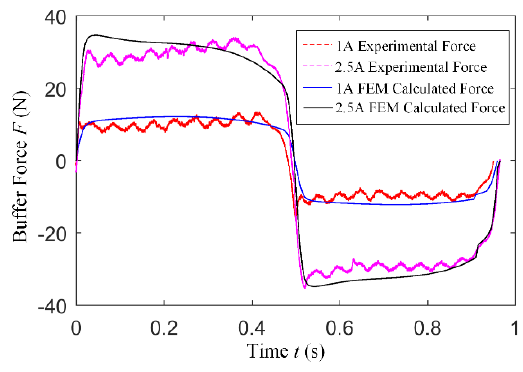
Figure 17. Buffer force curve at 1 Hz frequency.